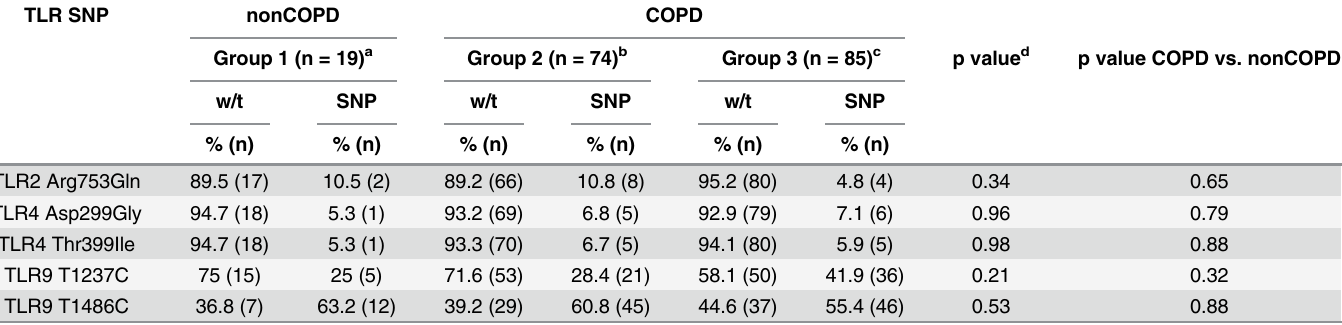
Table 4. Frequency of TLR polymorphisms. Frequency is shown of each TLR polymorphism (SNP) compared with wildtype (w/t) among each group of the total study population # . Statistical p values were determined by chi-square test. TLR